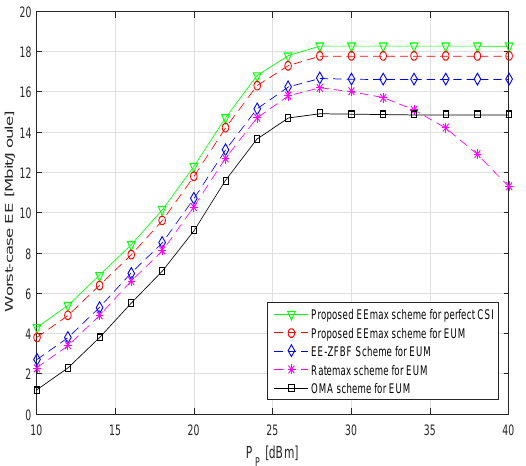
Figure 2. Worst-case energy efficiency (EE) versus transmission power P P